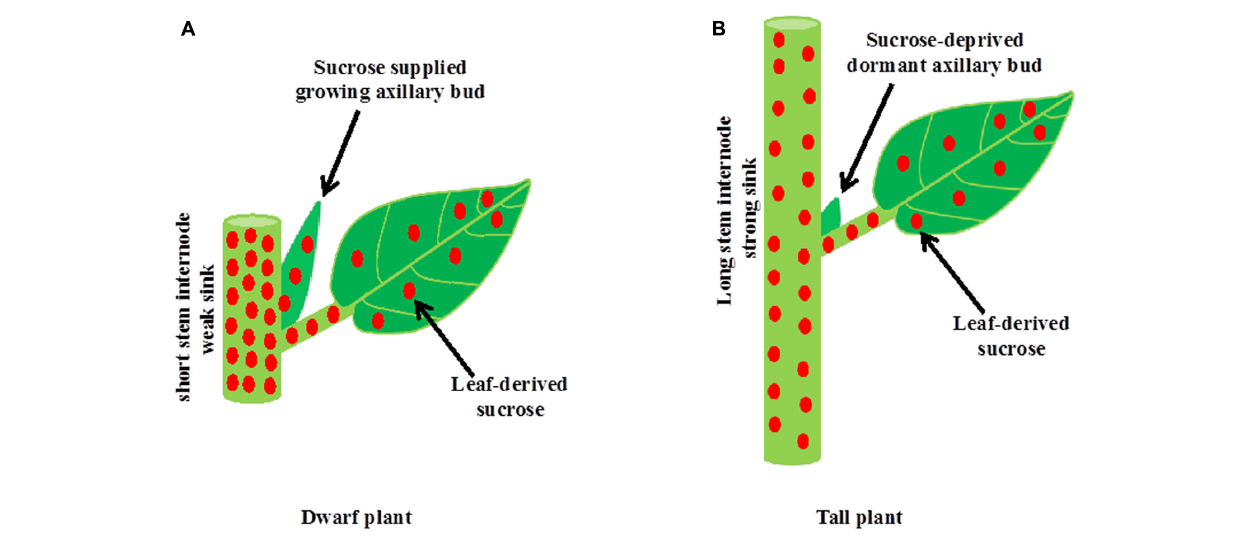
FIGURE 3 | A model for the inhibition of bud outgrowth by a growing stem. (A) The growth of stem intemodes in auxin or strigolactone deficient mutant plants or plants grown at high light intensity or low planting density is suppressed. A short intemode is not strong sink for sucrose. Therefore, excess sucrose exported from photosynthetic leaves to the stem overflow into axillary buds and induces bud outgrowth. (B) Intrinsic factors such as auxin and strigolactones and environmental factors such as shade promote stem intemode elongation in the main shoot. Elongated intemode, which is a strong sink, inhibits bud outgrowth indirectly by limiting sugar supply to axillary